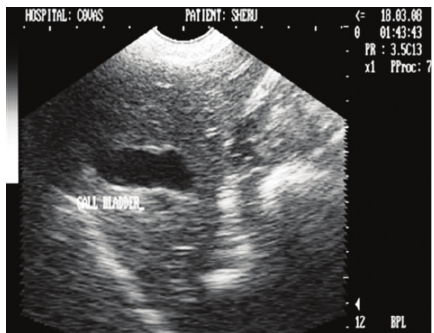
Figure 24: Hepatic sonogram (2D) in sagittal scan of a five-year- old intact Pomeranian male dog depicting increased parenchymal echogenicity with hyperechoic double rim appearance of GB